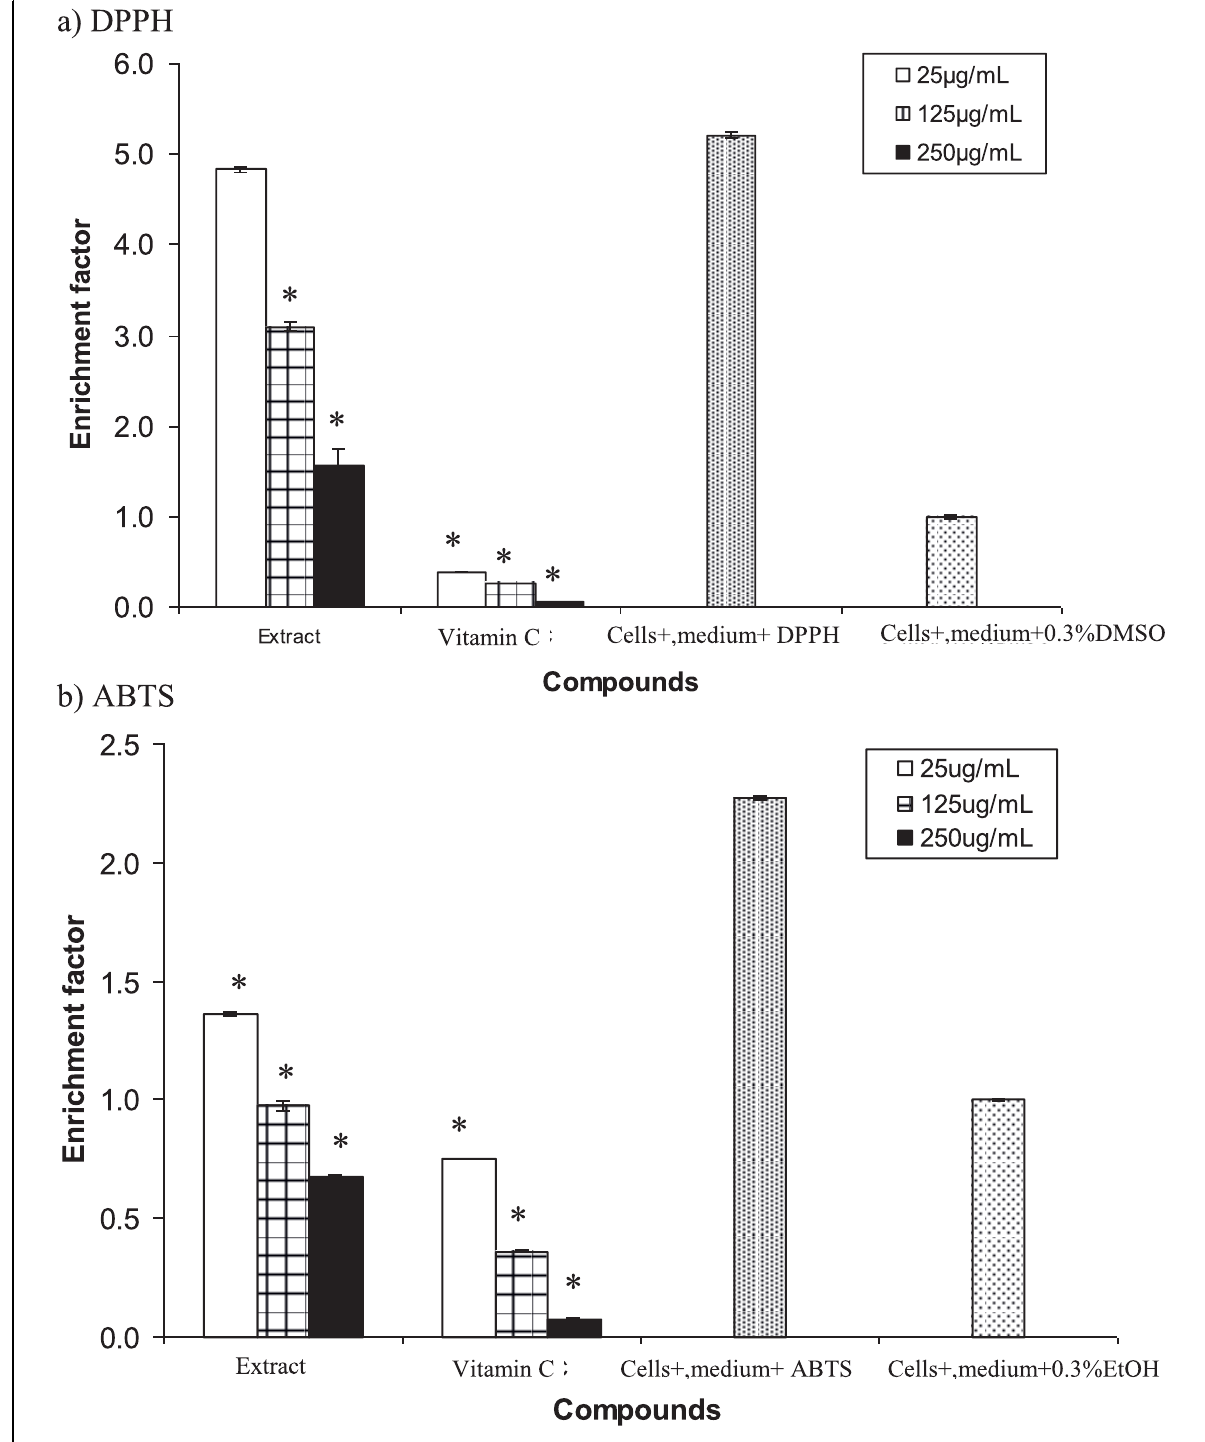
Figure 4 Protective effect of Spirulina extract against apoptotic cell death induced by a) DPPH and b) ABTS . The 3T3 cells were incubated in medium containing Spirulina extract or vitamin C for 1 h before being added with 20 μ M DPPH or 50 μ M ABTS and incubated for another 24 h before the determination of apoptotic cell death. The positive control contained cells incubated with vitamin C while the negative control contained medium alone. Data presented as mean ± standard deviation (n = 3). *Denotes significant difference (p < 0.05) from “ cells + medium + DPPH/ABTS ”